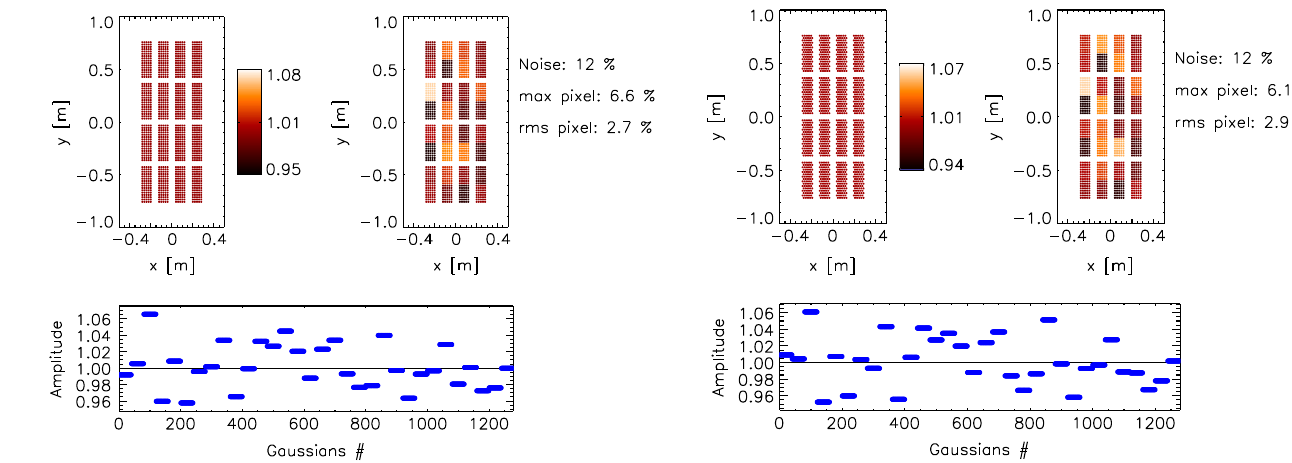
FIG. 12. Phantom 20 (top left) and its tomographic reconstruc- tion (top right) using the 32 pixel configuration with noisy data. The rms of the ratio noise/signal is